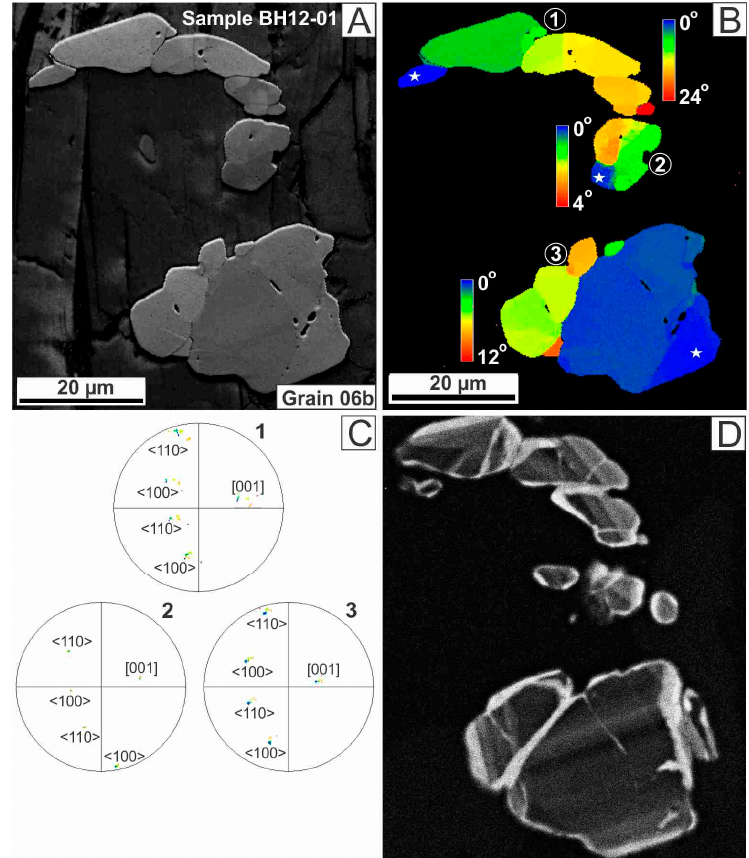
Figure 4. Data on the grain 06b, sample BH12-01. ( A ) EBSD pattern quality map revealing several detached fragments. ( B ) Cumulative misorientation or texture component EBSD map, showing the orientation of every data point with respect to a user-selected reference point (white star). Misorientation varies for each fragment according to the provided scales. ( C ) Lower hemisphere equal area projection pole figures, showing crystallographic axes [001], <100> and <110> orientation for each fragment. Color-coding as in corresponding EBSD maps in B. ( D ) Panchromatic CL image.